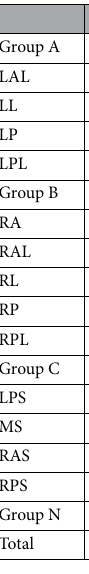
Table 1. Classifications of the accessory pathway locations. Accessory pathway locations and proportions. LAL left anterolateral, LL left lateral, LP left posterior, LPL left posterolateral, LPS left posteroseptal, MS right and left mid septal, RA right anterior, RAL right anterolateral, RAS right anteroseptal, RL right lateral, RP right posterior, RPL right posterolateral, RPS right posteroseptal. LAL, LL, LPL, and LP were defined as Group A, RA, RP, RPL, RL, and RAL were defined as Group B, RAS, LPS, MS and RPS were defined as Group C, and normal cases were defined as Group